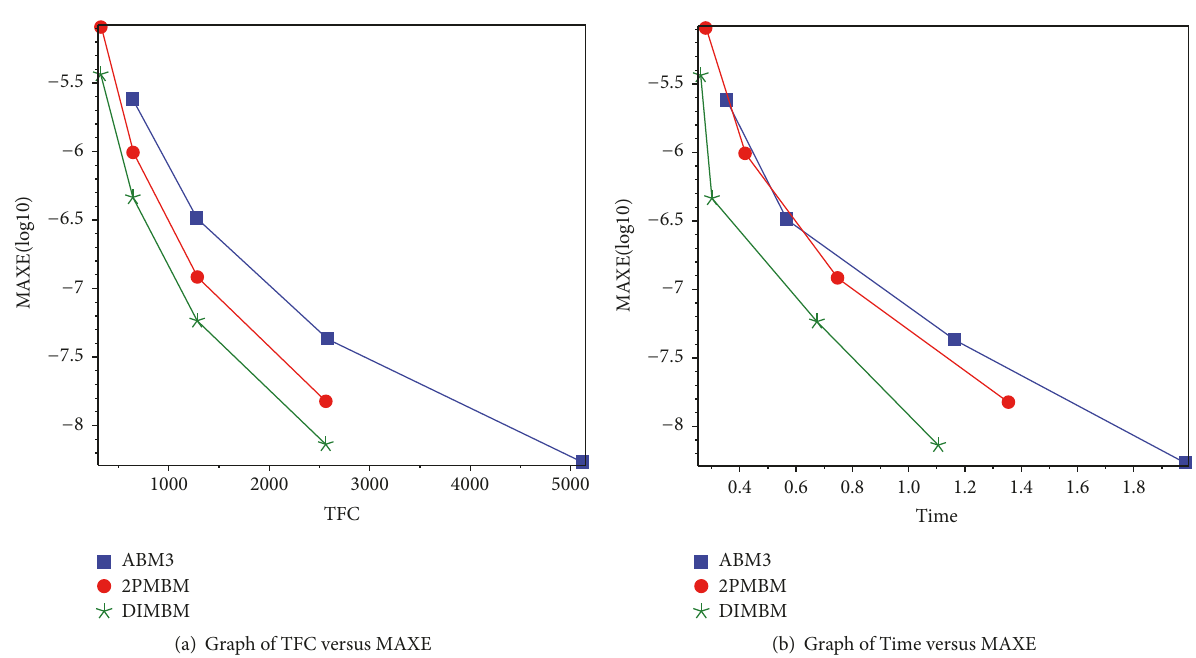
Figure 5: Graph of the numerical results when solving Example